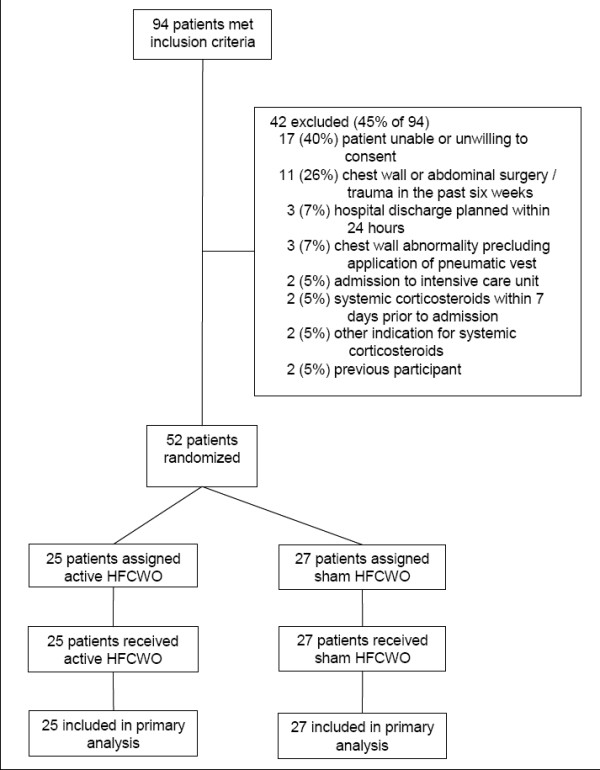
Flowchart of Study Cohort. N = 94 adults (age 18 years and older) admitted with a physician-diagnosis of acute asthma or COPD and with FEV1/FVC < 70% at the time of screening were assessed for eligibility. Fifty-two (55%) were randomized to active HFCWO (n = 25) or sham HFCWO (n = 27).